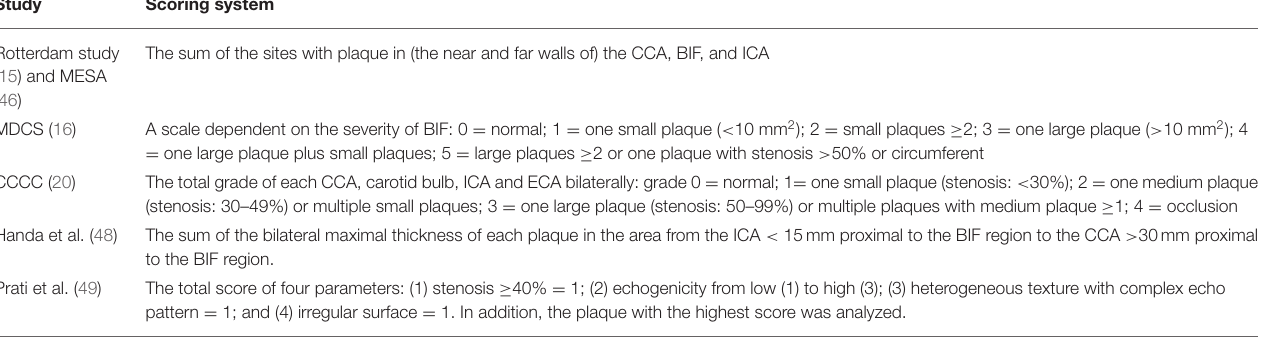
TABLE 3 | Differences between the carotid plaque scoring systems.